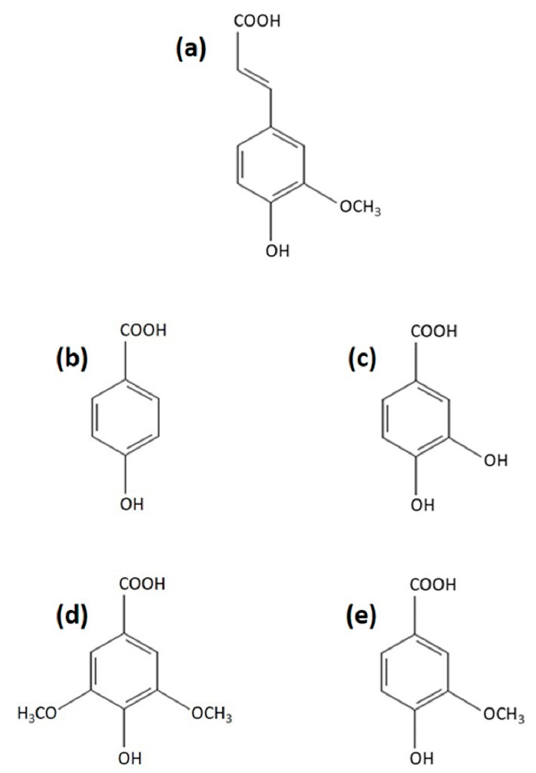
Figure 1. Chemical structure of: ( a ) ferulic acid, ( b ) p-hydroxybenzoic acid, ( c ) protocatechuic acid, ( d ) syringic acid, and ( e ) vanillic acid.